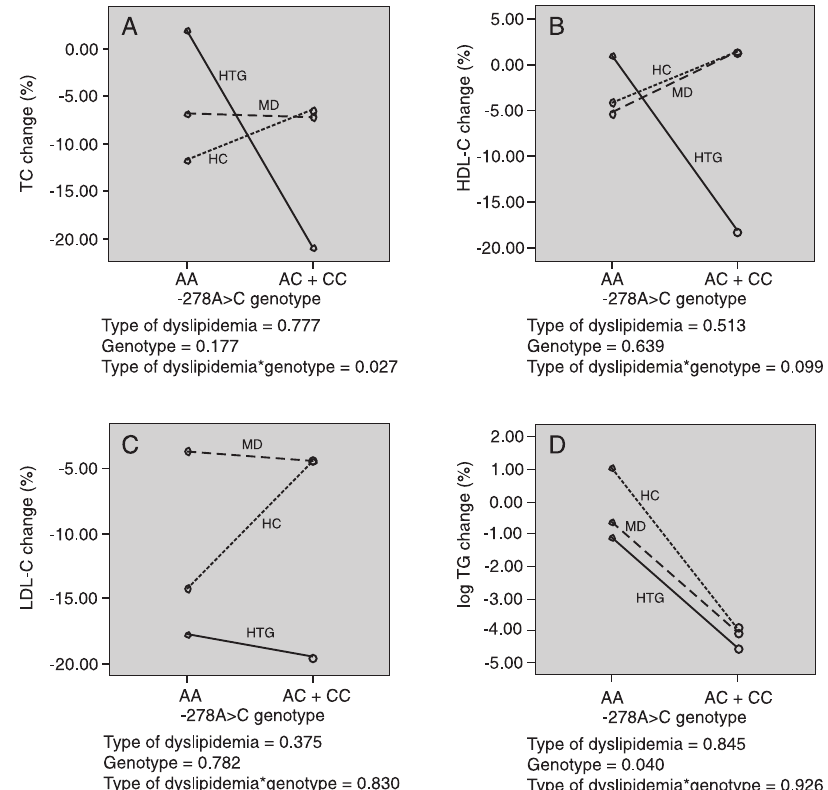
Figure 1. Adjusted means for changes (%) in A, total cholesterol (TC); B, high-density lipoprotein cholesterol (HDL-C); C, low-density lipoprotein cholesterol (LDL-C), and D, log of triglyceride (TG) concentrations (mg/dL), and the influence of the type of dyslipidemia [hypercholesterolemia (HC), hypertriglyceridemia (HTG), and mixed dyslipidemia (MD)], -278A>C genotypes (genotype), and the interaction of type of dyslipidemia and genotype (type of dyslipidemia*genotype) in patients with a 6- to 8-week low-fat diet. Only hypertriglyceridemic carriers of -278C allele had significant reduction in TC concentrations (interaction type of dyslipidemia*genotype; P = 0.027; Figure 1A). No significant association between genotypes and type of dyslipidemia and changes in HDL-C (Figure 1B) and LDL-C (Figure 1C) concentrations was observed. Carriers of -278C allele showed significantly greater reductions in TG concentra- tions than AA homozygotes (genotype; P = 0.04), independent of type of dyslipidemia (interaction type of dyslipidemia* genotype; P = 0.926; Figure 1D).